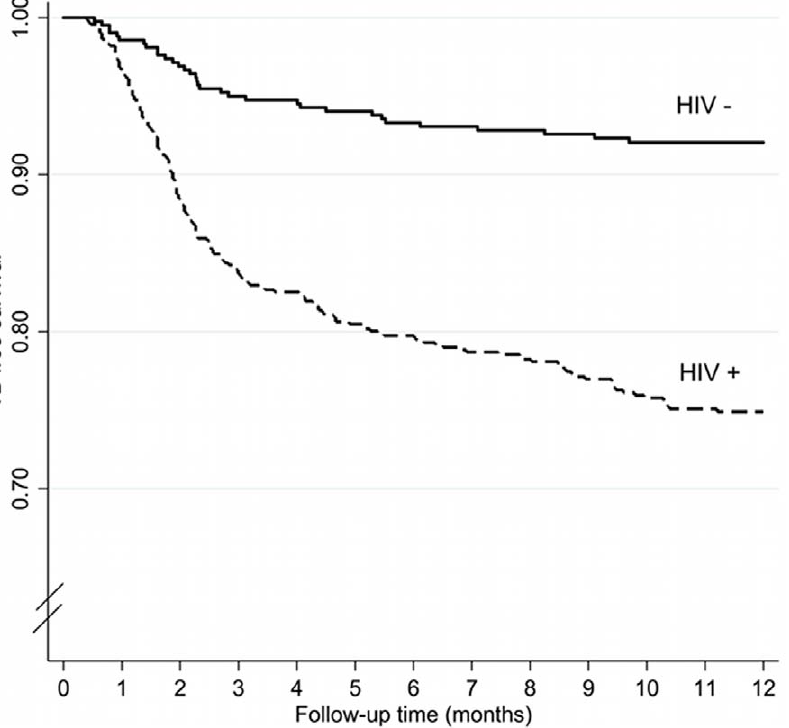
Figure 2. TB free survival stratified by HIV status. Kaplan-Meier estimates showing TB-free survival of cohort members stratified by HIV status. doi:10.1371/journal.pone.0011849.g002 PLoS ONE |